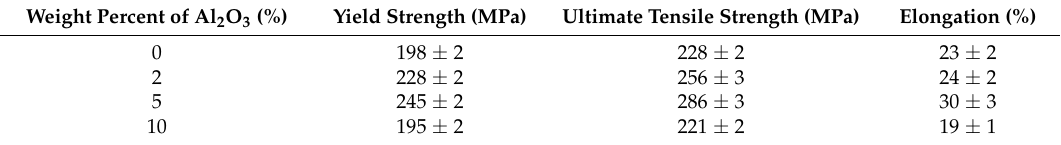
Figure 5. The tensile true stress-true strain curves of Al-12Si/Al 2 O 3 nanocomposites produced by the hot extrusion method. Table 2. Tensile properties of the as-extruded Al-12Si/Al 2 O 3 nanoparticle-reinforced composites.